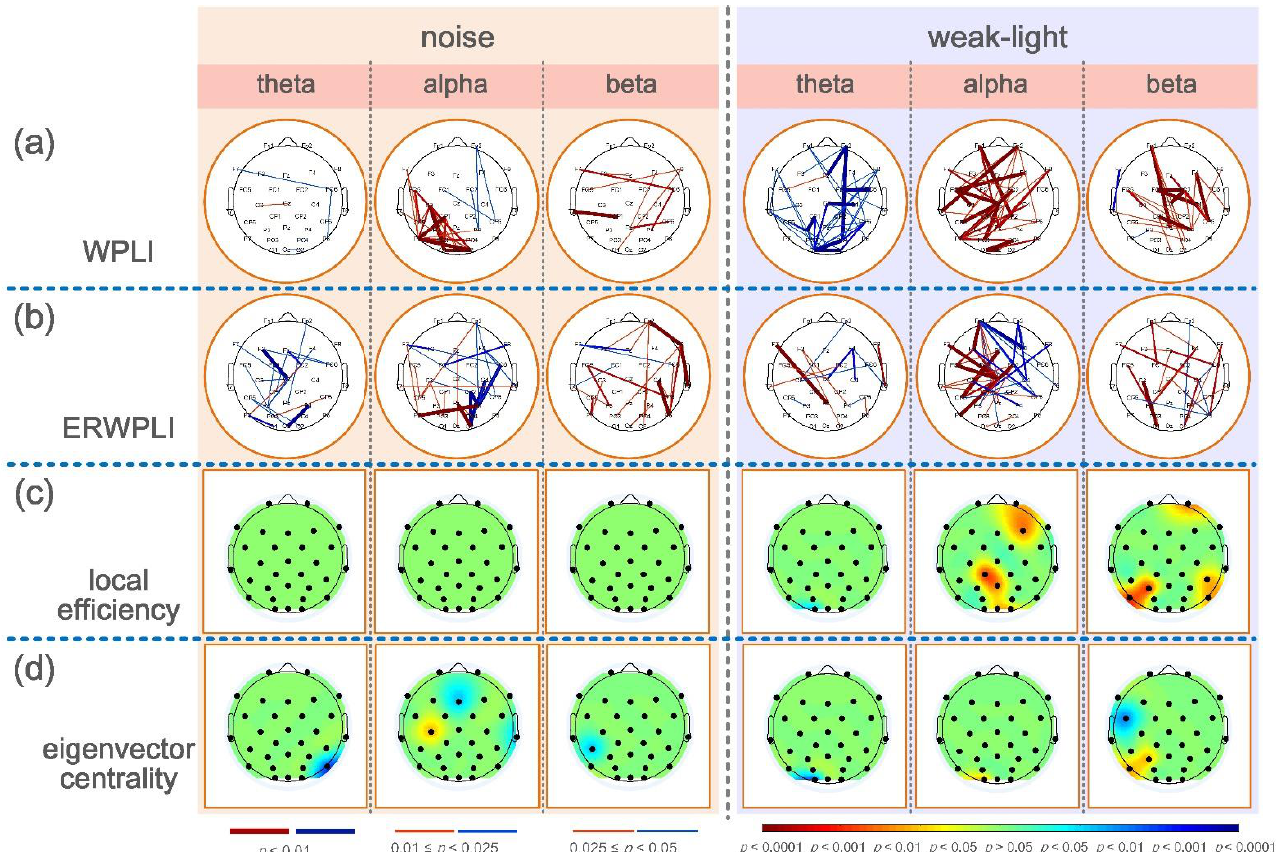
Figure 5. ( a , b ) WPLI and ERWPLI of skilled shooters in the theta, alpha, and beta bands are significantly correlated with shooting performance in the noise and weak-light conditions ( p < 0.05). Red and blue shows positive ( r > 0) and negative ( r < 0) correlations. ( c , d ) Brain topographic maps showing the correlation between local efficiency, eigenvector centrality, and shooting performance. Red/blue is the electrode position with a significant positive/negative correlation with shooting performance.